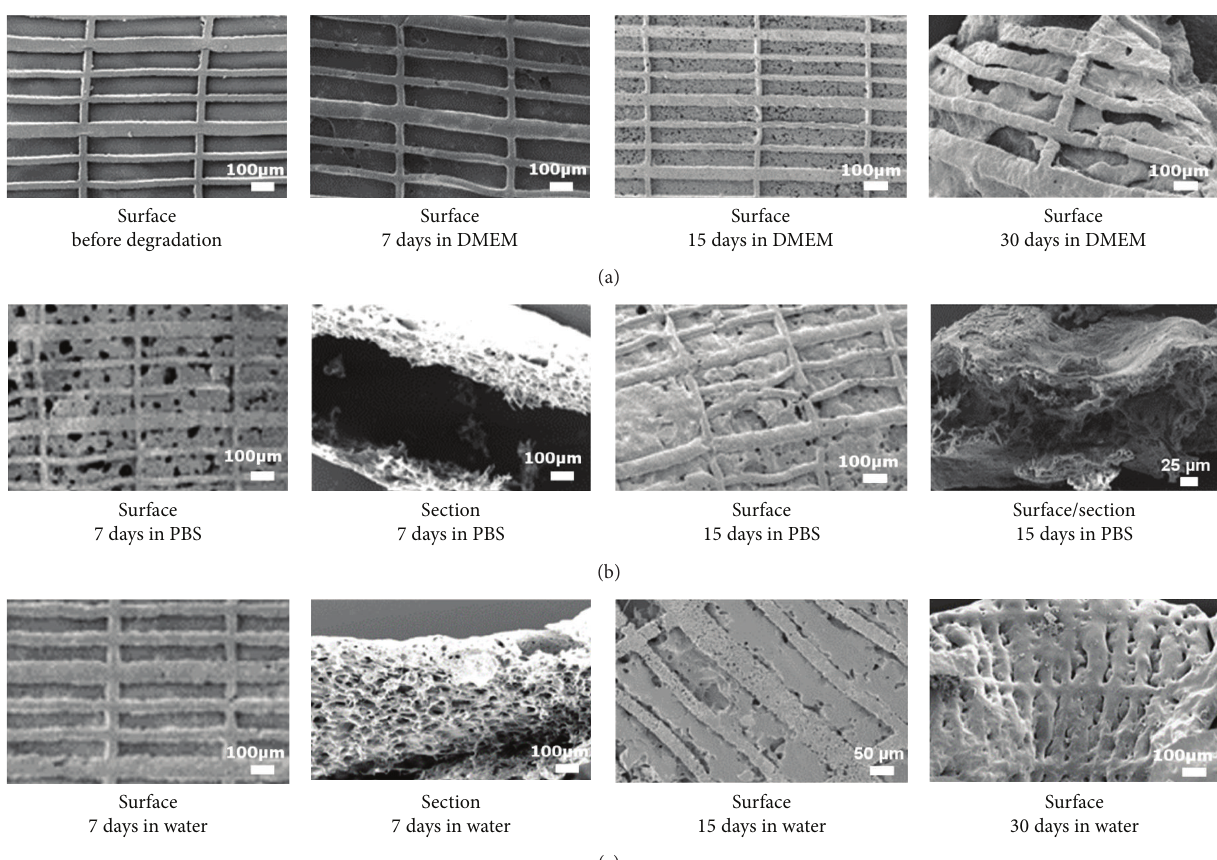
Figure 6: (a) SEM images of the surface of bilayer PLGA/gel 70/30, from left to right, before degradation, after 7, 15 and 30 days of incubation in DMEM; (b) SEM images of a bilayer PLGA/gel 70/30 from left to right in surface and section after 7 days, in surface after 15 and 30 days in PBS; (c) SEM images of a bilayer PLGA/gel 70/30 from left to right in surface and section after 7 days, in surface after 15 and 30 days in MilliQ